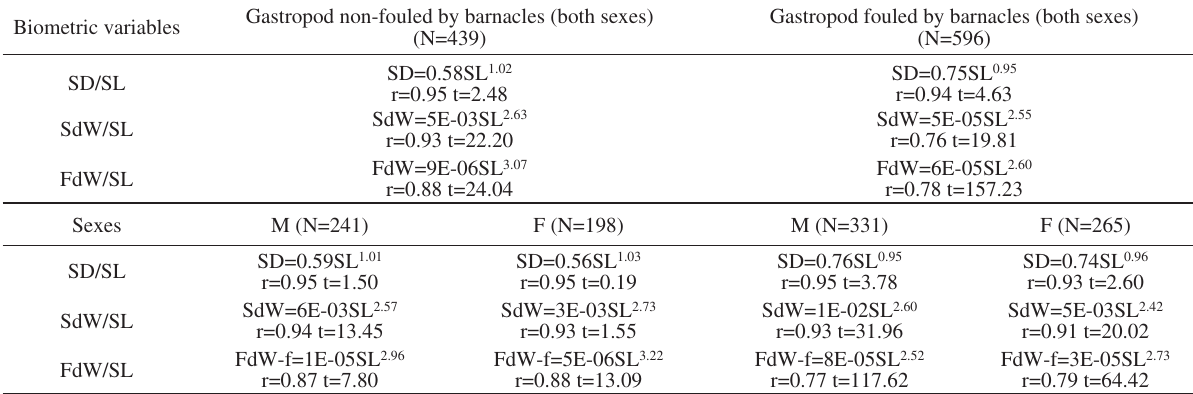
Table 3. – Relative growth of non-fouled and fouled S. haemastoma (sexes confounded and separate sexes). SL, shell length; SD, shell diame- ter; SdW, Shell dry weight; FdW, Flesh dry weight; N, number of individuals; M, males; F, females; r, correlation coefficient; t, Student t-test. Biometric variables